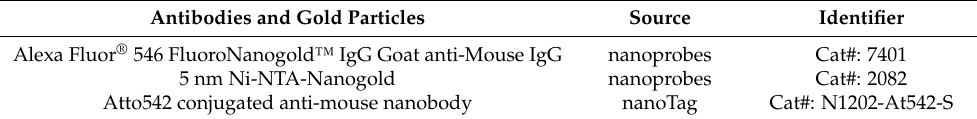
Table 2. Cont. Antibodies and Gold